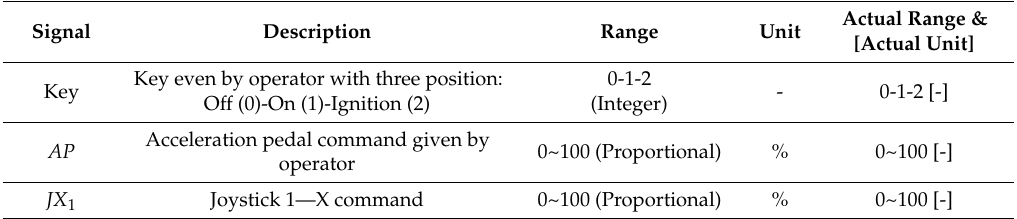
Table 4. Definition of HMI signals and environment